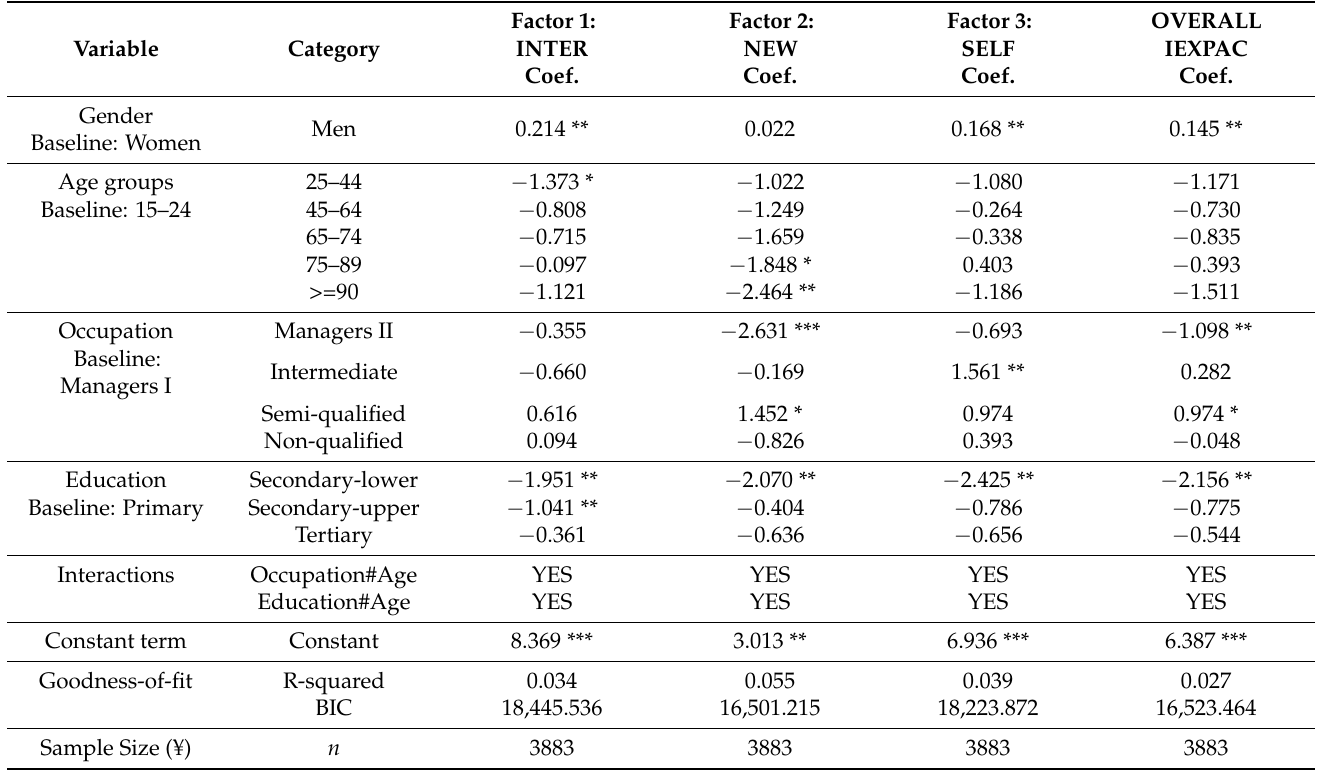
Table 3. Model 1—WLS results. Differences in health care experience among patients with self-declared chronic conditions. The effect of sociodemographic and economic